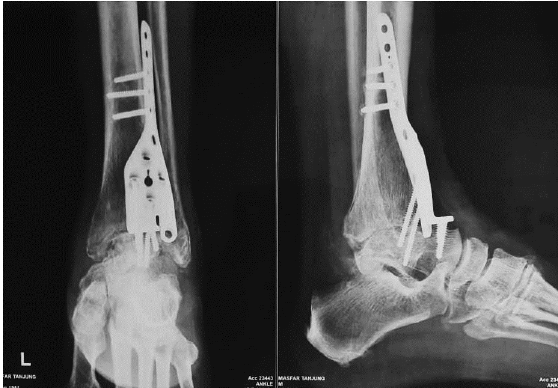
Figure 4. Illustration of modi fi ed RUST score (8) consisted of (1) anterior; (2) posterior; (3) lateral; and (4)